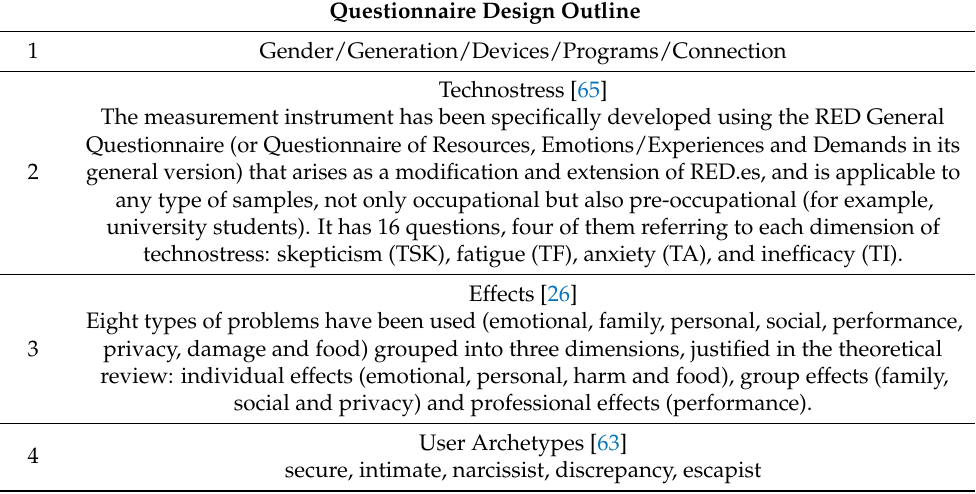
Figure 1. Research design. Table 1. Instrument